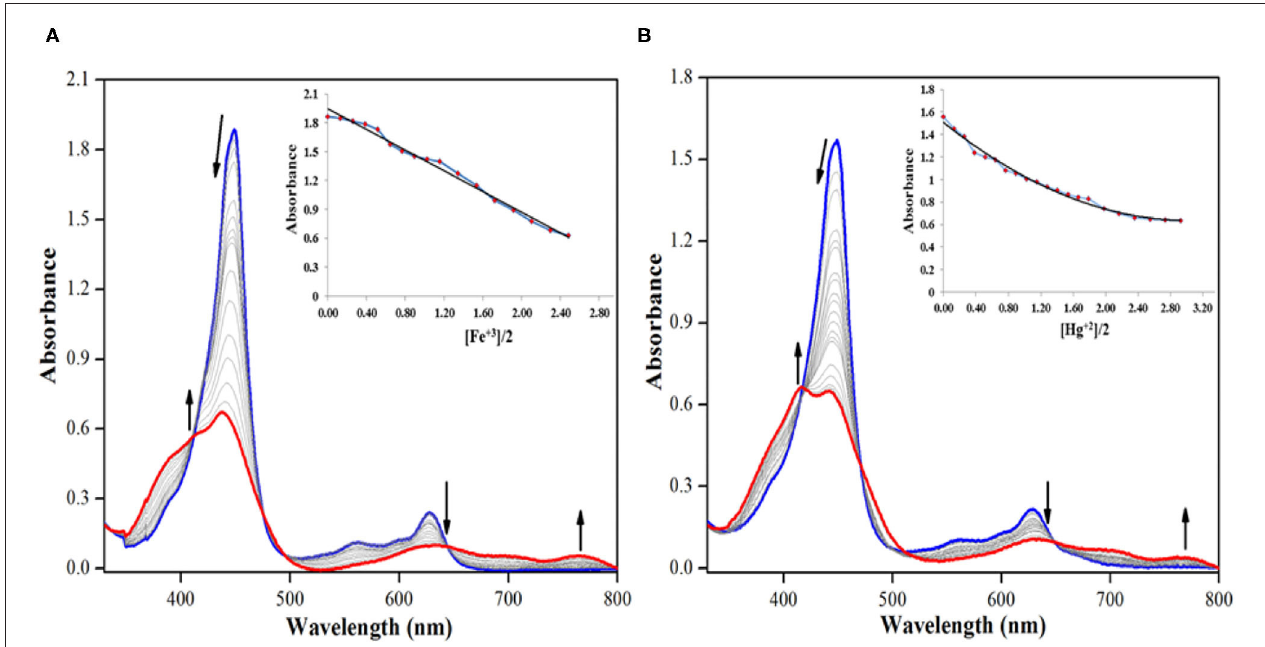
FIGURE 7 | UV-visible spectral titration of 2 on adding (A) 0–4.55 × 10 − 5 M, 3.5 equiv. of Fe + 3 ions and (B) 0–4.55 × 10 − 5 M, 3.5 equiv. of Hg + 2 ions in distilled CHCl 3 at 298K. Insets show decrease in absorbance at 447nm against [cation conc./ 2